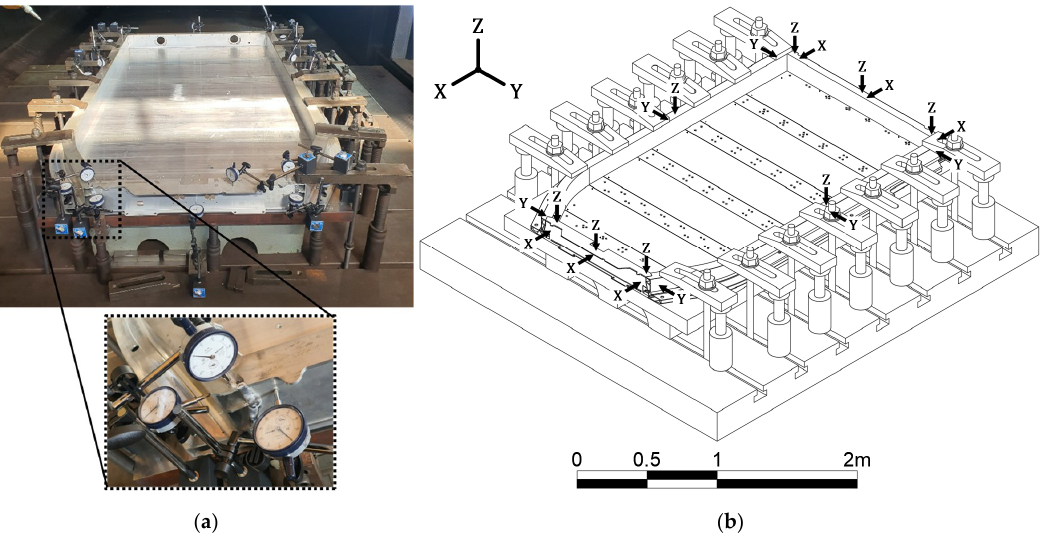
Figure 20. FSW deformation measurement of actual full-frame structural: ( a ) Position of dial indicator; ( b ) measurement direction of deformation.